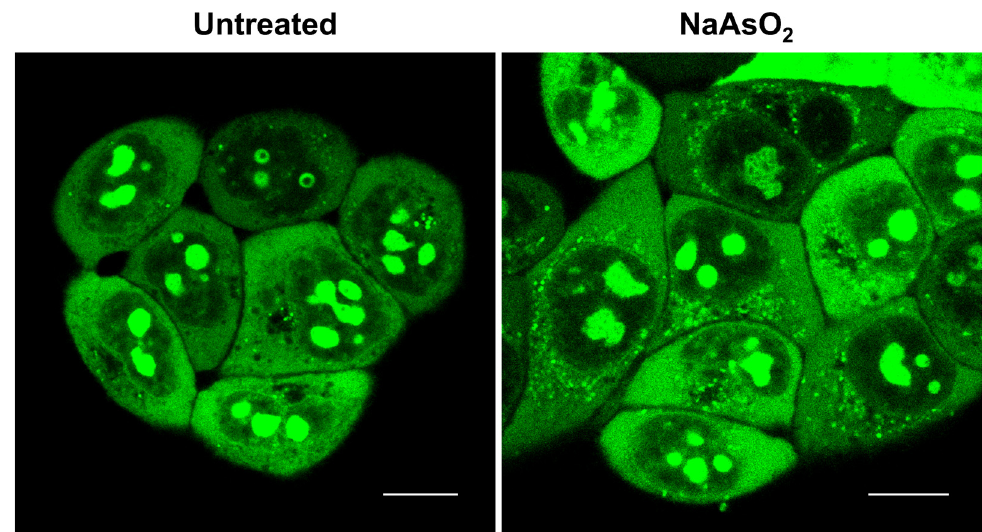
Figure 7. Imaging of live HeLa cells treated without or with sodium arsenite (500 μ M) and stained with QUID − 2 (0.5 μ M, λ ex = 488 nm, λ em = 500–600 nm, green). Scale bars for cell image: 10 μ